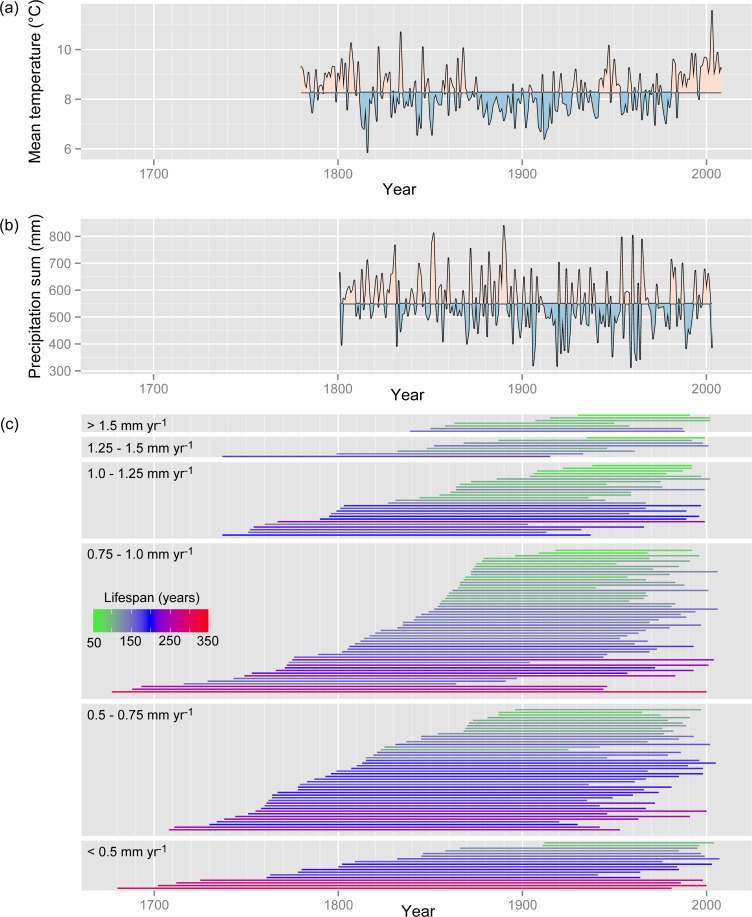
Comparison of temperature and precipitation with establishment and mortality of mountain pines.(a) Mean temperatures (May to September) from 1780 to 2008. Shaded colors indicate values above and below the overall mean temperature (8.27°C); (b) precipitation sums (May to September) from 1801 to 2003. Shaded colors indicate values above and below the overall mean precipitation (550 mm); (c) line plot of crossdated increment cores. Each horizontal line extends from the year of establishment (represented by the formation year of the first tree ring, corrected for missed rings) to the approximate year of mortality (represented by the formation year of the last tree ring) of a dead mountain pine. The same number of trees and classes of early growth as in Fig 1 are shown. Within each class of early growth, the trees were ordered according to the year of establishment. The color gradient indicates the lifespan of the trees.